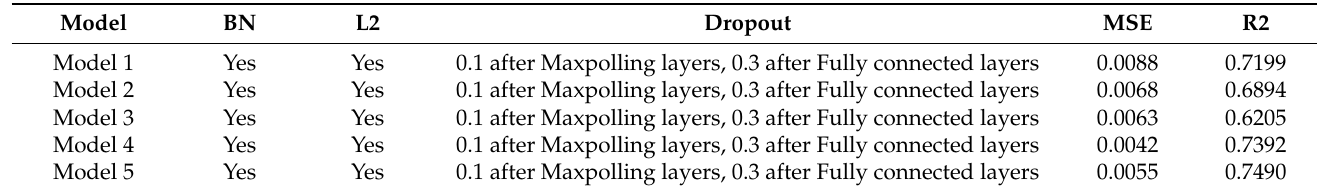
Table 3. Prediction results of regularization methods for different